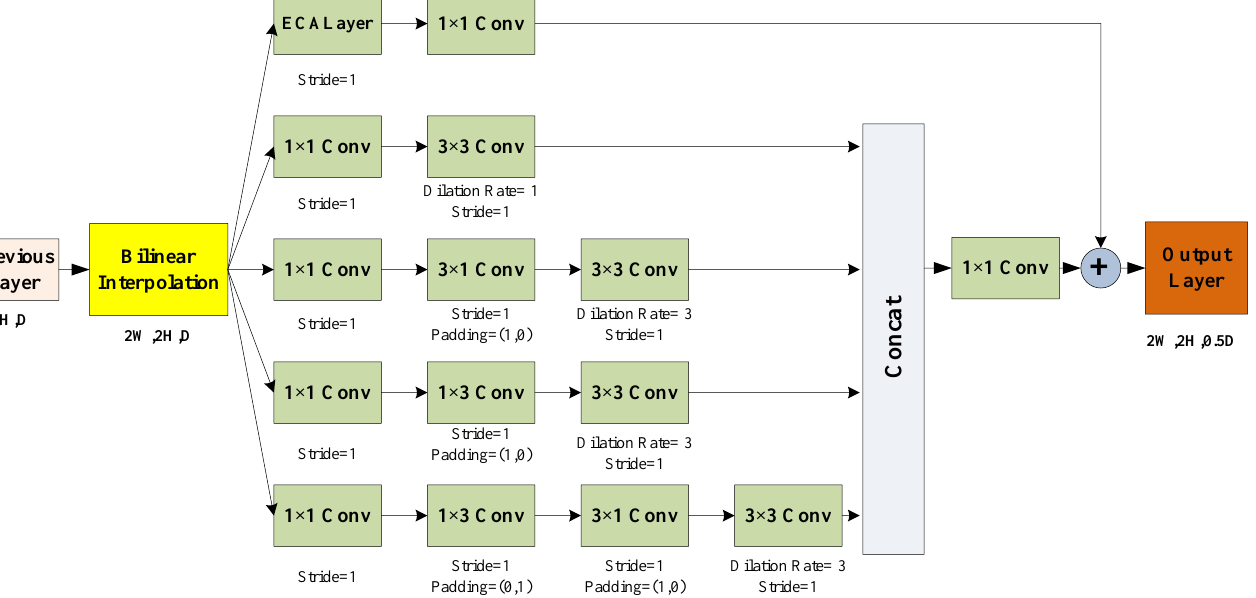
Figure 8. Upsampling structure with channel attention and asymmetric convolution kernel.